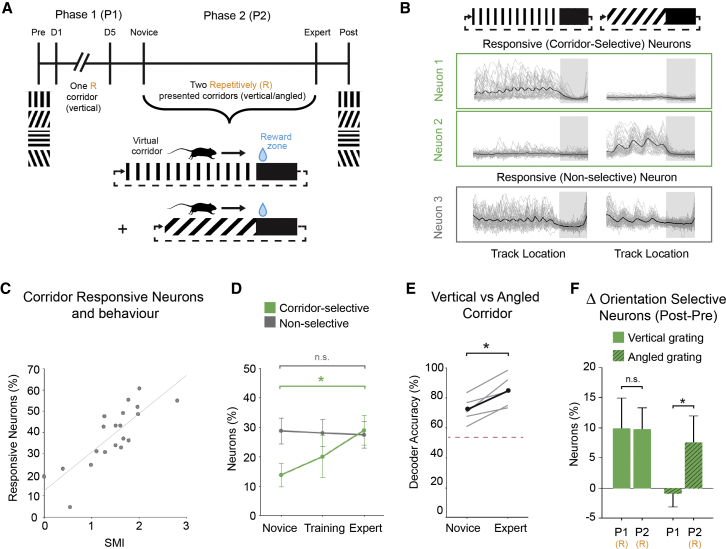
Enhanced Representations of Two Repetitively Presented and Equally Rewarded Stimuli(A) Experimental timeline. Orientation selectivity was assessed on the day before (pre) phase 1 (P1) training with a single virtual corridor (vertical gratings) followed by phase 2 (P2), where two virtual corridors were repetitively presented with a water reward, and a final assessment of orientation selectivity (post).(B) Responses (ΔF/F0) of 3 example neurons; individual trials (gray) and average response (black). Neuron 1 and 2: corridor-selective responses are shown. Neuron 3: corridor responsive neuron is shown, not selective for a single corridor grating but responsive to both corridors.(C) Correlation between the percentage of corridor-responsive neurons and the behavioral performance (spatial modulation index [SMI]; R = 0.82; p < 0.001; n = 15 [novice, mid-training, and expert sessions from 5 mice]; Pearson’s coefficient).(D) Proportion of corridor-specific (green) and corridor-responsive (gray) neurons on the first day of phase 2 (novice), the midpoint training day (i.e., after first half of training days; training), and the last day of training (expert). Increase in the percentage of corridor-selective neurons from novice to expert day is shown (p = 0.047; n = 5; Wilcoxon signed rank).(E) Accuracy of a template-matching decoder to determine which corridor grating (vertical or angled) was presented per trial for the novice and expert day (p = 0.031; n = 5; Wilcoxon signed rank). Dashed line represents chance level.(F) Change in the proportion of orientation selective neurons from pre to post day for both vertical gratings (p = 0.905; Mann-Whitney U test) and angled gratings (p = 0.032; Mann-Whitney U test) for animals that only had phase 1 (P1; 4 mice) and animals that had both phase 1 and phase 2 (P2; 5 mice). Repetitively presented stimuli are indicated (R). All panels, error bars: SEM.